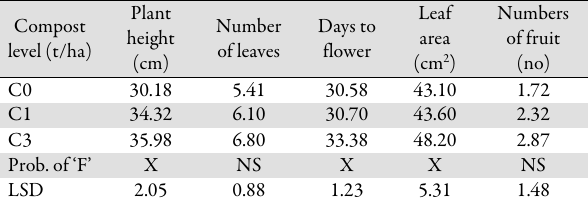
Table 8. Effect of compost application on the vegetative growth of okra on the field Plant Compost height level (t/ha) (cm)